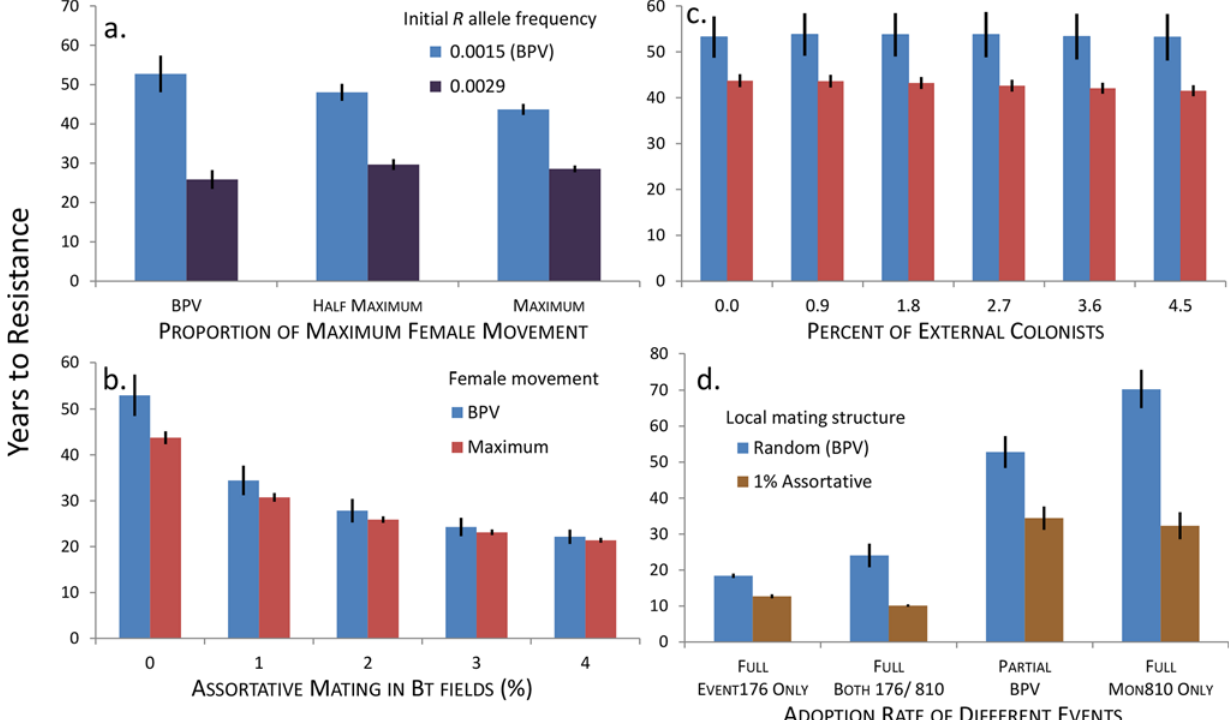
Fig 3. Predicted rate of resistance evolution for Sesamia nonagrioides in northeast Spain. Mean years to resistance ( R allele frequency (cid:3) 0.5) for the interactions a) between amount of female movement and initial R allele frequency (BVP indicates the best parameter values, including the level of non-compliance to the refuge recommendation; Maximum: all females leave natal site before mating and leave mating site before ovipositing; Half Maximum: female movement parameters are halfway between BPV and Maximum); b) between local assortative mating in Bt fields and maximum female movement (initial R allele frequency = 0.0015); c) between level of external colonization and maximum female movement (legend as in 6b) (initial R allele frequency = 0.0015) d) between adoption rate of different Bt maize events and local assortative mating in Bt fields (Full: 80% adoption from year 1; Partial: observed adoption rates to 2014 and full adoption thereafter; Both 176/810: sum of adoption of Event 176 and MON 810 is 80% from year 1, and the proportion of each equals the observed proportion to 2014 and only MON 810 thereafter; initial R allele frequency = 0.0015); error bars are standard deviations of 1000 random simulations.